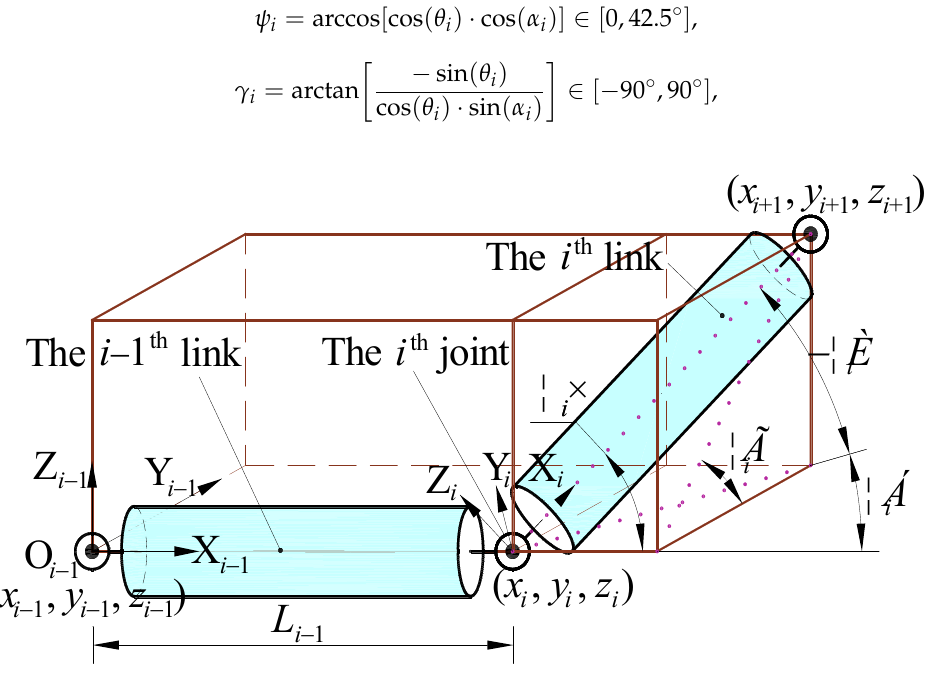
Figure 2. Schematic diagram of the joint angle and link angle.